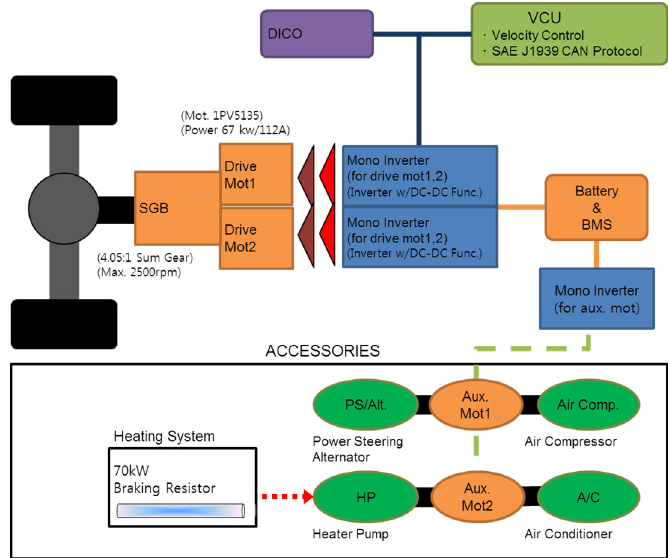
Figure 2. Overall architecture of electric